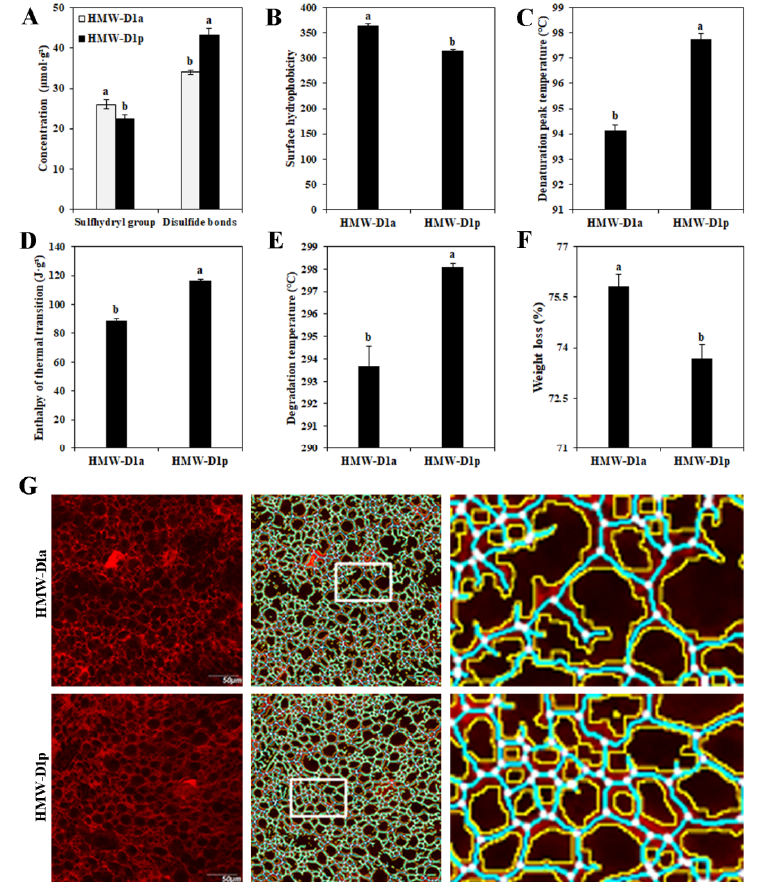
Figure 1. Structural-thermal characteristics of gluten from HMW-D1a and HMW-D1p in 2017–2018 growing season. ( A ) Concentrations of sulfhydryl groups and disulfide bonds in gluten; ( B ) Surface hydrophobicity of gluten; ( C – F ) Thermal properties of gluten; G, Dough microstructures, the images in the left column are the original images and the scale bar represents 50 µ m. The images in the middle column were processed with AngioTool. The images in the right column show the enlarged areas selected from the processed images highlighted by the white boxes, where the junctions are shown in white, the protein skeleton in blue, and the protein outline / area in yellow. Results followed by a di ff erent letter in the same column within the same group are significantly di ff erent ( p <